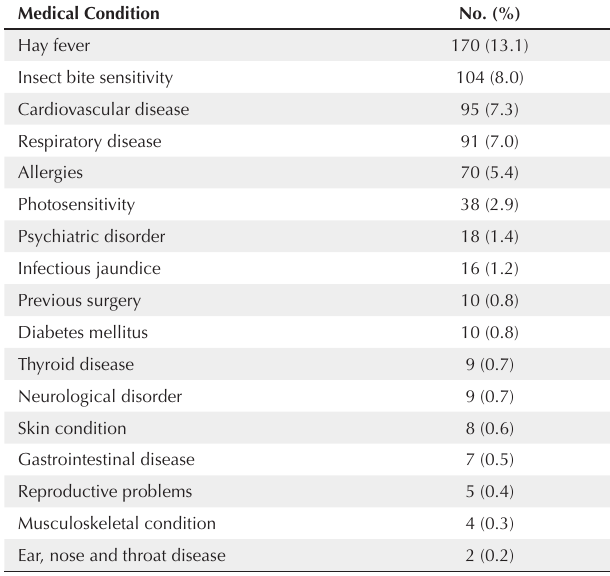
Table 2. Past Medical History of Last-Minute